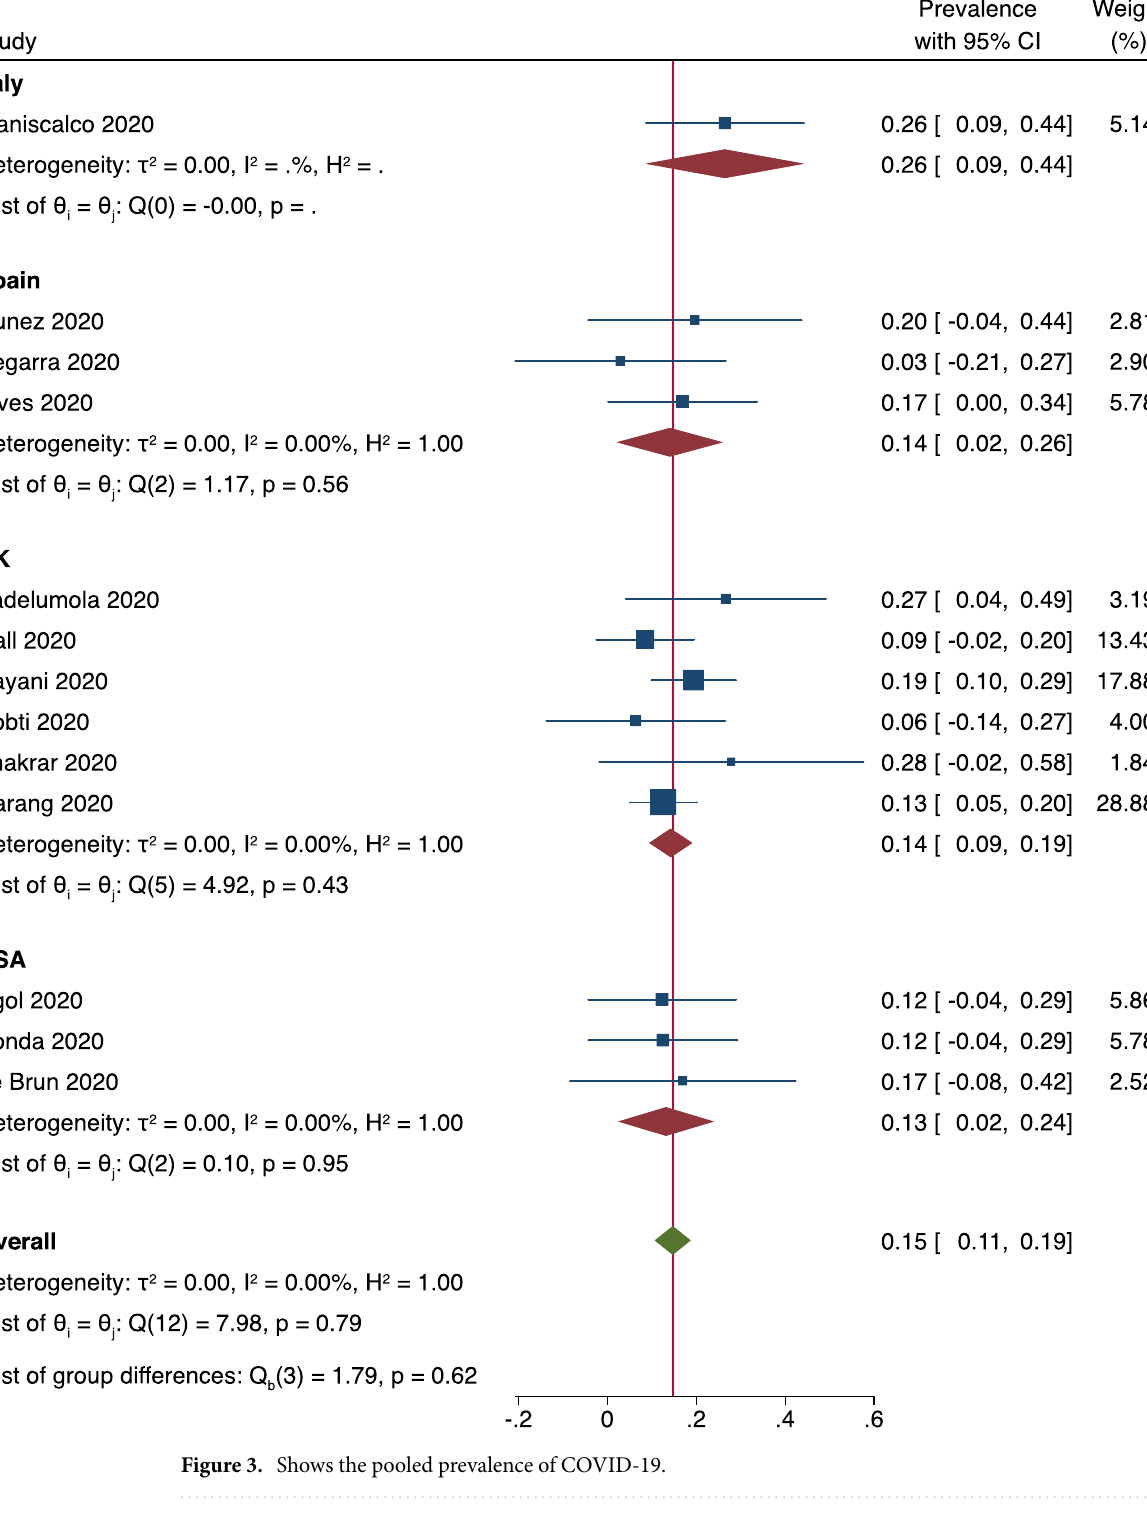
Figure 3. Shows the pooled prevalence of 30-day mortality for COVID-19 positive vs non-positive COVID-19 patients. Eight studies 7,30–32,34,39–41 assessed the impact of COVID-19 positive status on 30-day mortality of hip fracture patients showing a 38% (95% CI 0.32–0.44) 30-day mortality for COVID-19 positive patients in comparison to 7% (95% CI 0.06–0.08) for non- COVID-19 positive patients. We performed a time-to-event meta-analysis using an inverse variance random effects model to obtain a pooled hazard ratio HR of 4.73 (95% CI 3.26–6.86) [Z = 8.19, p < 0.0001] as shown in Fig. 5b. Variation in the pooled HR attributable to heterogeneity was low, I 2 = 0.0%, p = 0.529. Studies that reported 30-day mortality were of moderate or good quality, and thus sensitivity analysis was unchanged 7,30–32,34,39–41 .